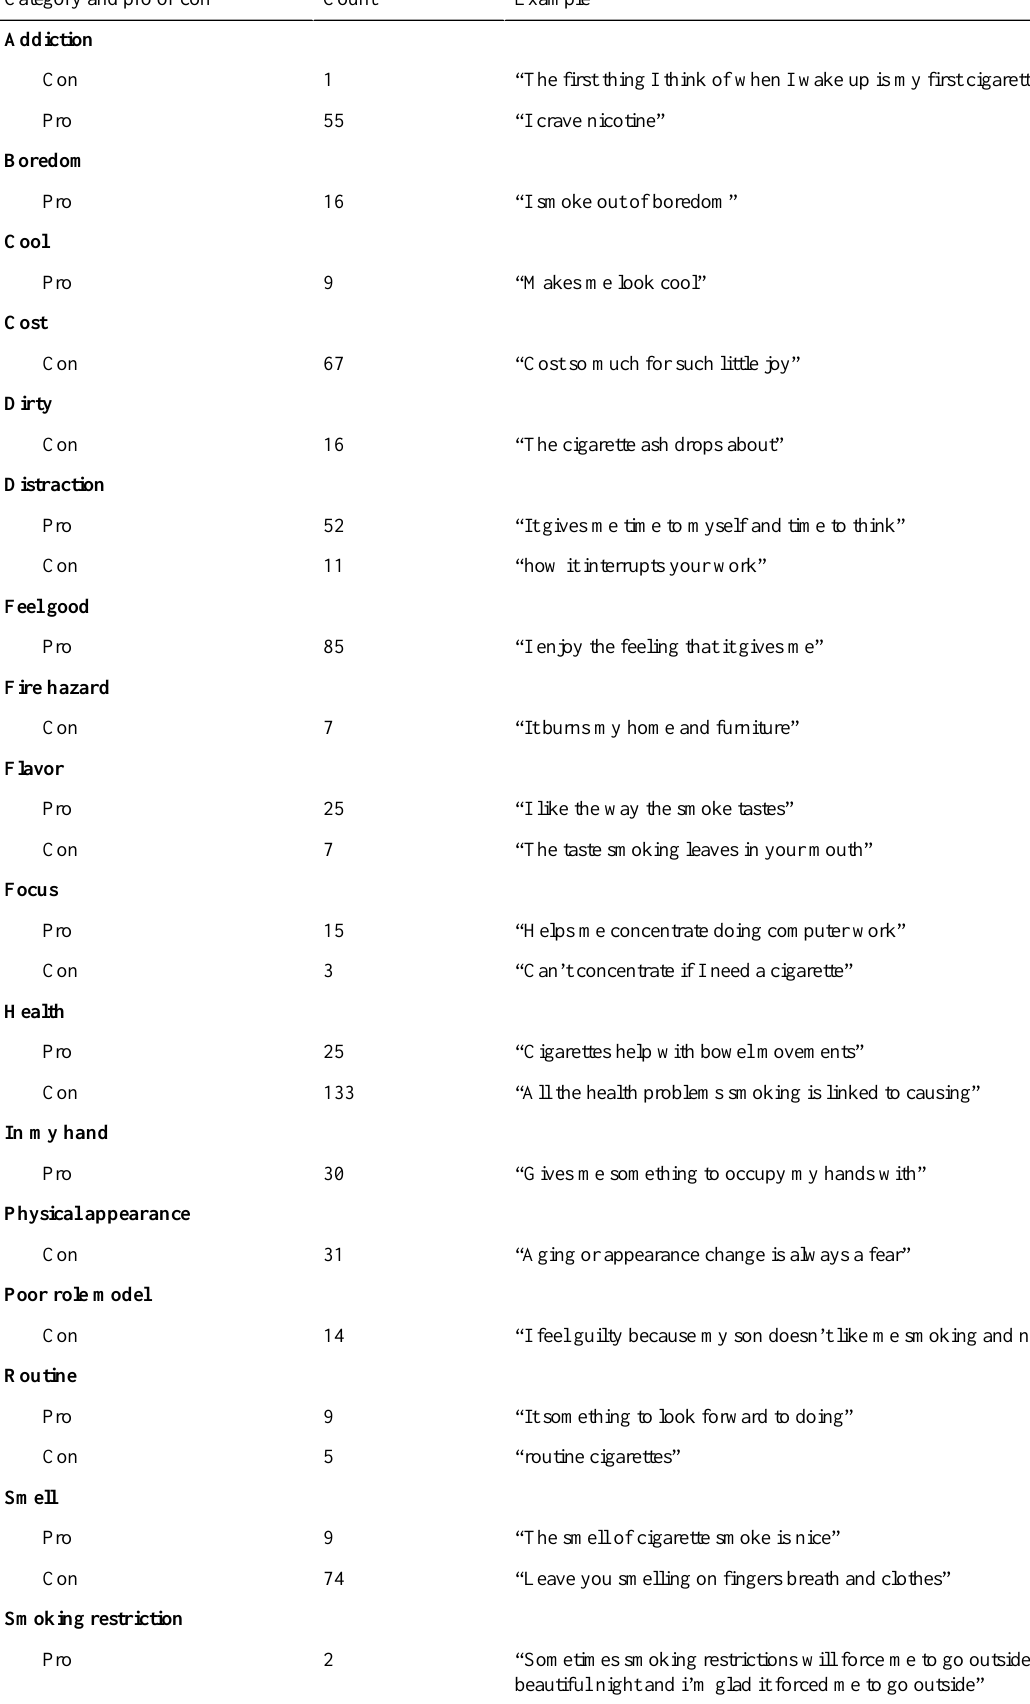
Table 3. A list of all the smoking reason categories used in the conversation. ExampleCountCategory and pro or